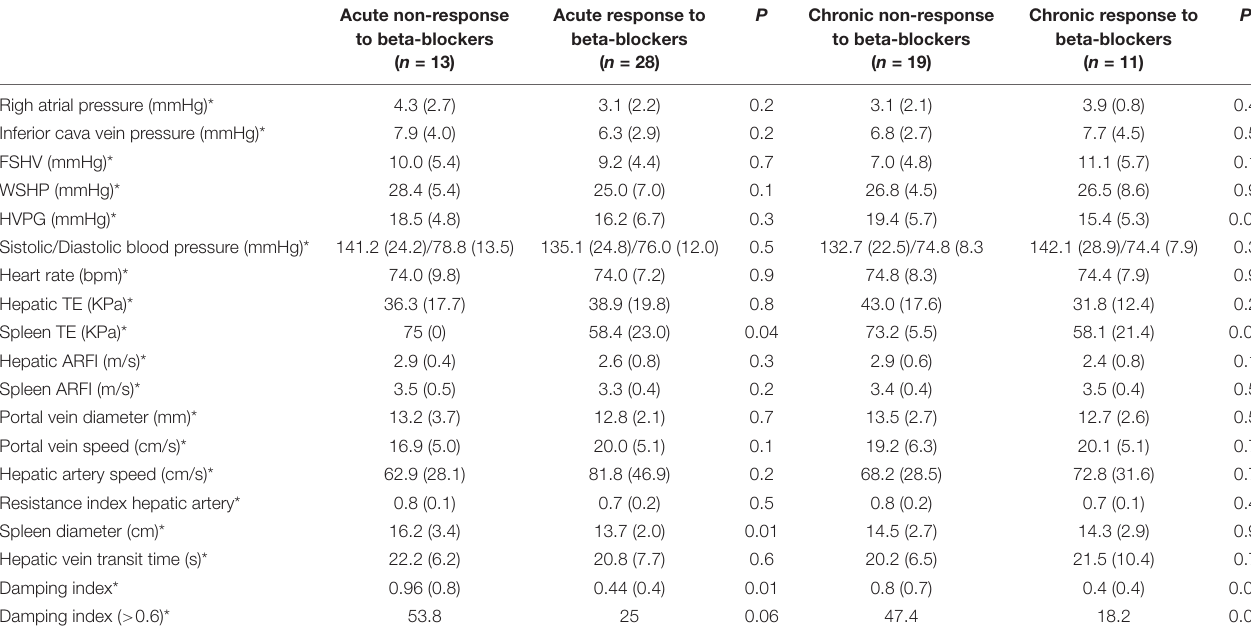
TABLE 3 | Univariate analysis among baseline invasive and non-invasive measurements between acute responders and non-responders to